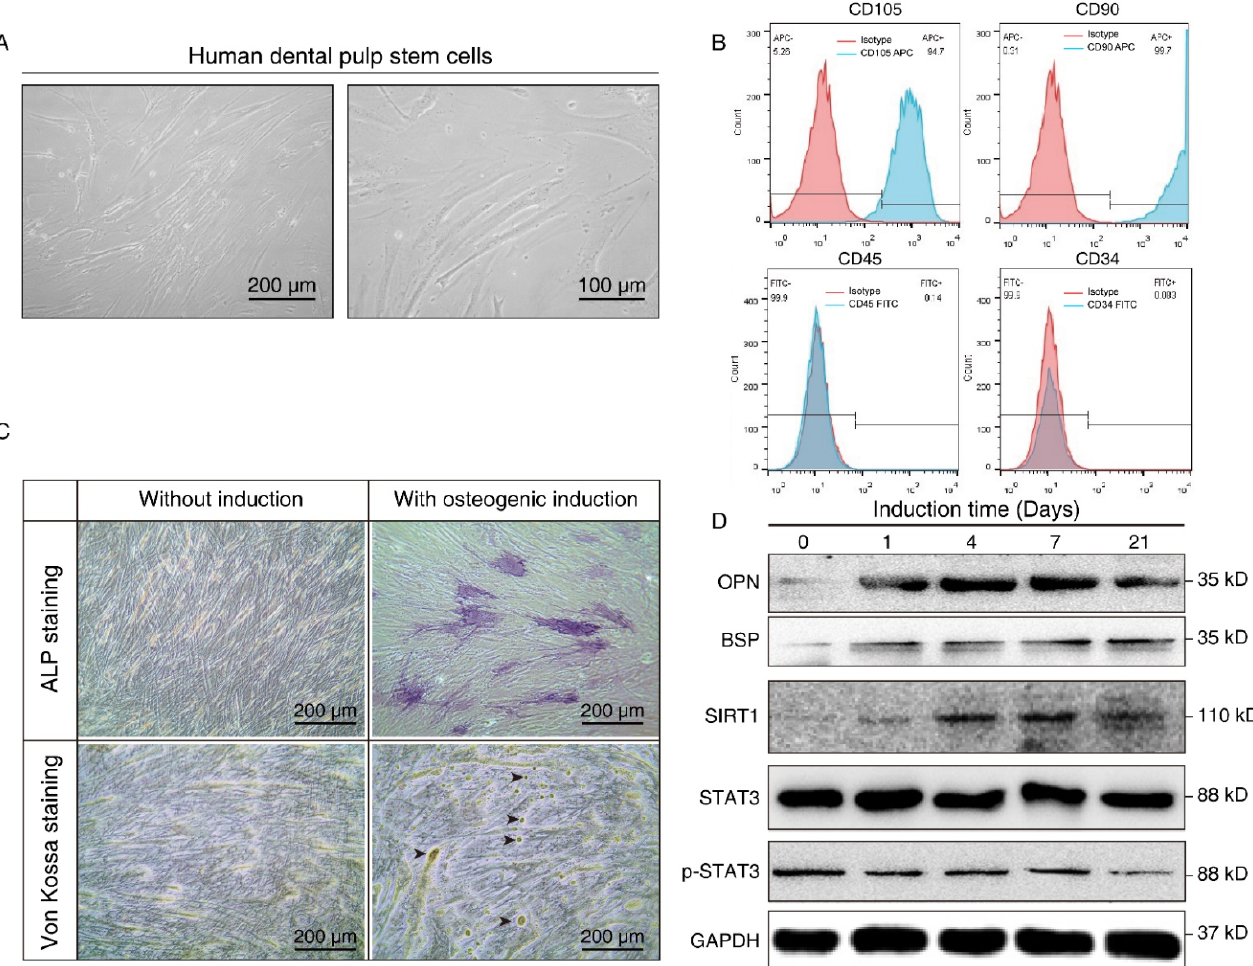
Figure 2. Isolation, characterization, and osteogenic differentiation of hDPSCs. ( A ) Morphology of hDPSCs. hDPSCs showed a fibroblast-like morphology after 14 days of osteogenesis. ( B ) Immunophenotype analysis of the first passage of hDPSCs by flow cytometry. hDPSCs were stained with cell surface marker antigens CD105, CD90, CD45, and CD34. ( C ) ALP staining (upper panel) and von Kossa staining (lower panel) were performed on day 14 with or without osteogenic induction. Long-term culture of hDPSCs in the differentiation medium showed the capacity to form bone nodules. Arrows indicate osteogenesis. ( D ) Western blot showing the expression pattern of osteogenesis markers (BSP, OPN), SIRT1, and p -STAT3 at different time points during osteoblast differentiation. OM: Osteogenic induction medium, RSV: Resveratrol.